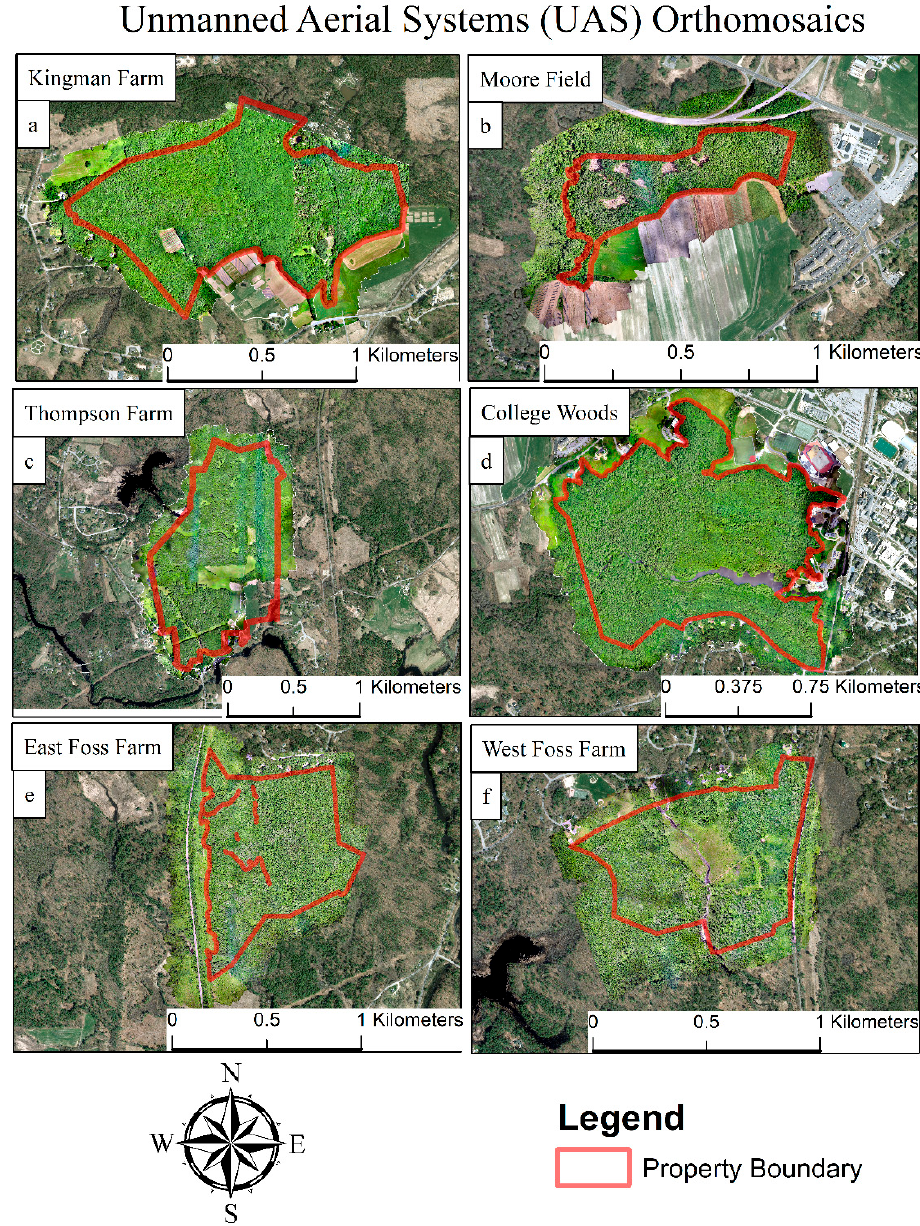
Figure 5. UAS orthomosaics for the six woodland properties (Top left to Bottom Right): ( a ) Kingman Farm, ( b ) Moore Field, ( c ) Thompson Farm, ( d ) College Woods, ( e ) East Foss Farm, ( f ) West Foss Farm.